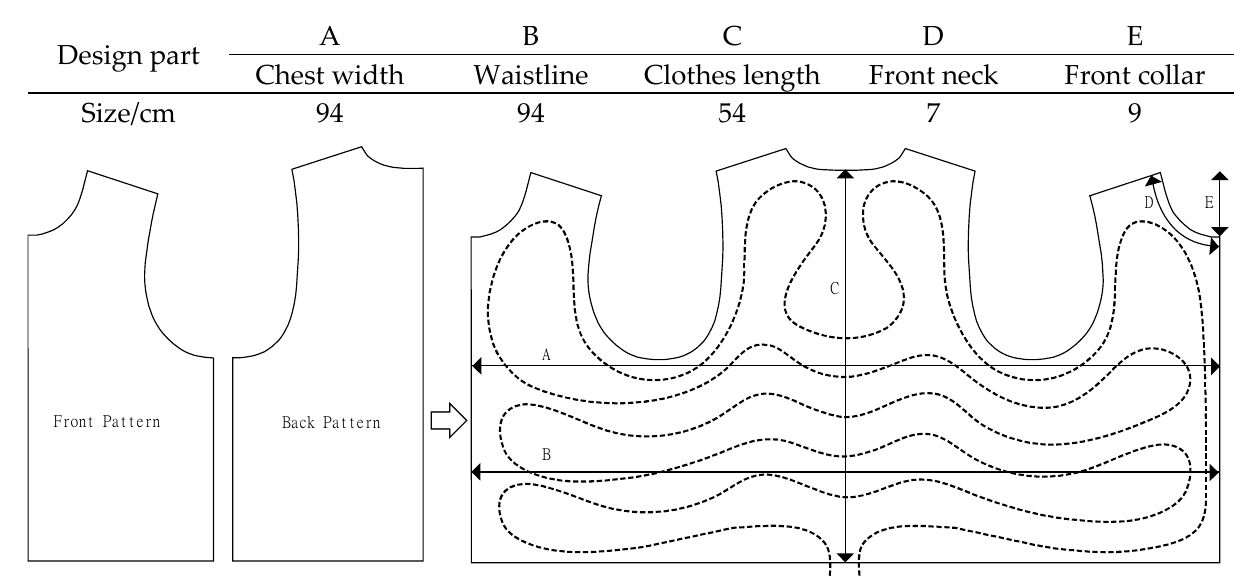
Figure 1. Anthropometric measures for heat exchange mechanism.